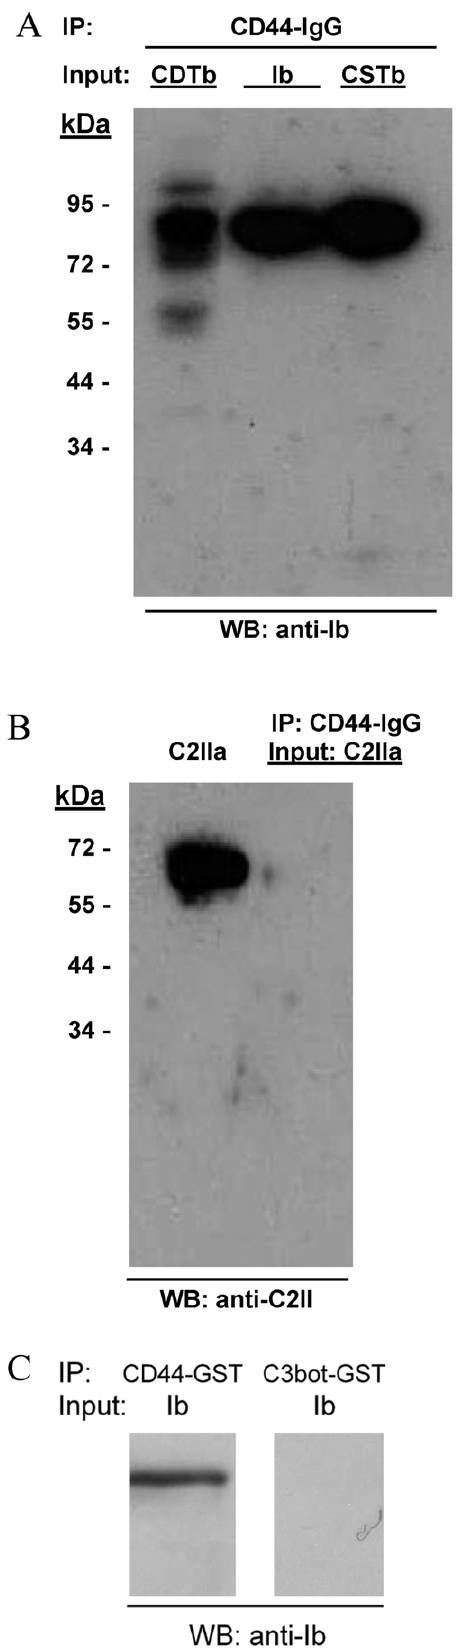
Figure 4. Binding of iota-family B components to purified CD44 in solution. ( A and B ) The B component (10 m g) of each toxin was added to CD44-IgG (10 m g in 50 m l) at room temperature for 60 min. Protein A - agarose beads were then added for 5 min at room temperature, gently centrifuged, and washed with buffer. SDS-PAGE sample buffer containing reducing agent was added to the beads, the mixture heated, and protein separated from the beads by centrifuga- tion. Supernatant proteins were then resolved on a 10% gel, transferred onto nitrocellulose, and clostridial B component detected with either 1:1000 dilutions of rabbit anti-Ib (Panel A) or anti-C2II sera (Panel B). Protein A - peroxidase conjugate was used to detect bound antibody, and following washes, specific bands were visualized with chemilumi- nescent substrate. (C) Like the CD44-IgG construct, Ib also binds specifically to a CD44-GST construct. A GST version of C. botulinum C3 exoenzyme, used as a negative control, does not bind to Ib in pull- down experiments done similarly for panels A and B, with an